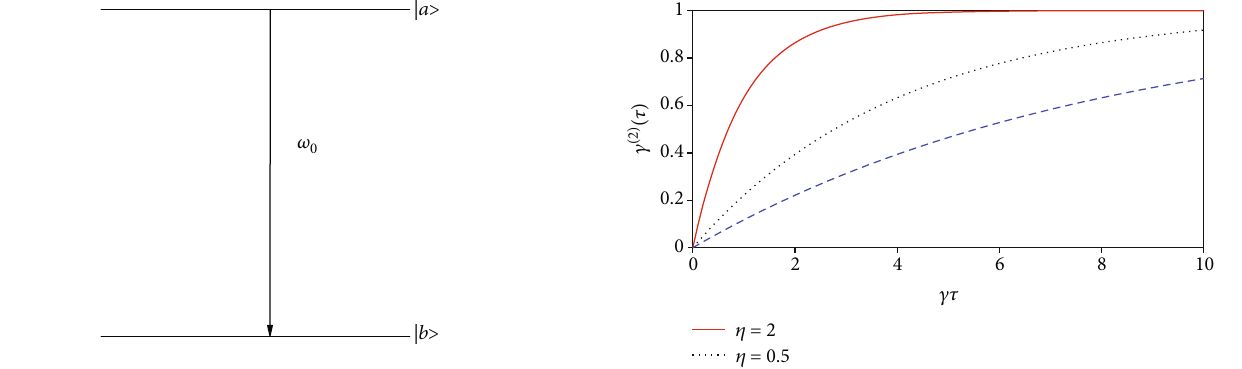
Figure 1: Scheme of a two level